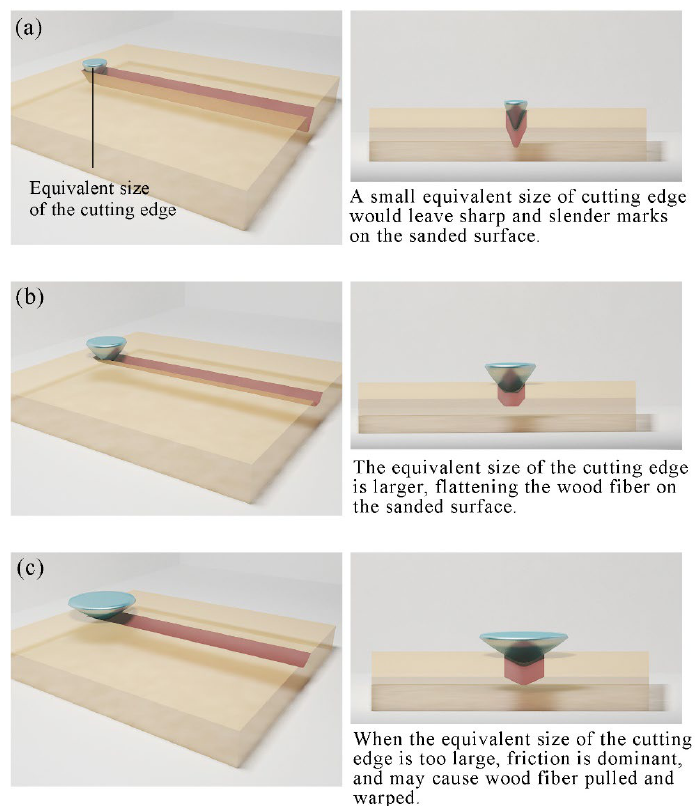
Figure 5. Surface morphology with different equivalent cutting-edge sizes: ( a ) small equivalent size; ( b ) large equivalent size; ( c ) excessive equivalent size.